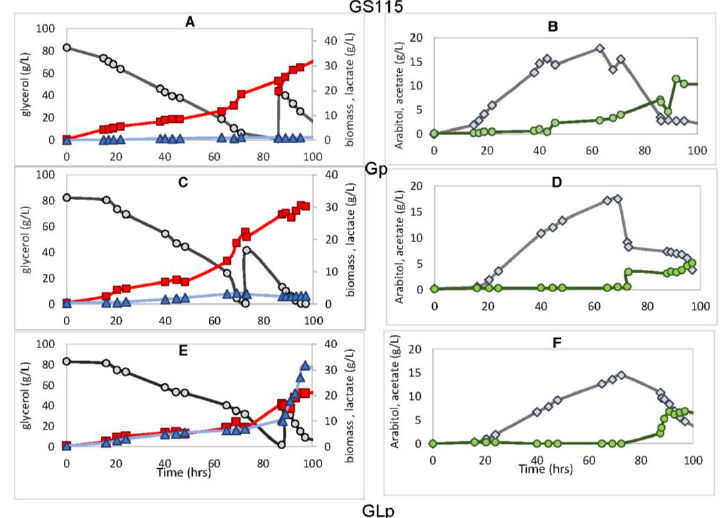
Figure 3. Fermentation profile of the strains GS115 ( A , B ), Gp ( C , D ), and GLp ( E , F ) showing consumption of glycerol (gray circle) and the production of biomass (red square), lactate (blue triangle), arabitol (gray diamond) and acetate (green circle). 4% glycerol was added at 70–80 fermentation hours when oxygen was limited. Experiments were performed in biological triplicates, and the figure shows a typical fermentation profile.